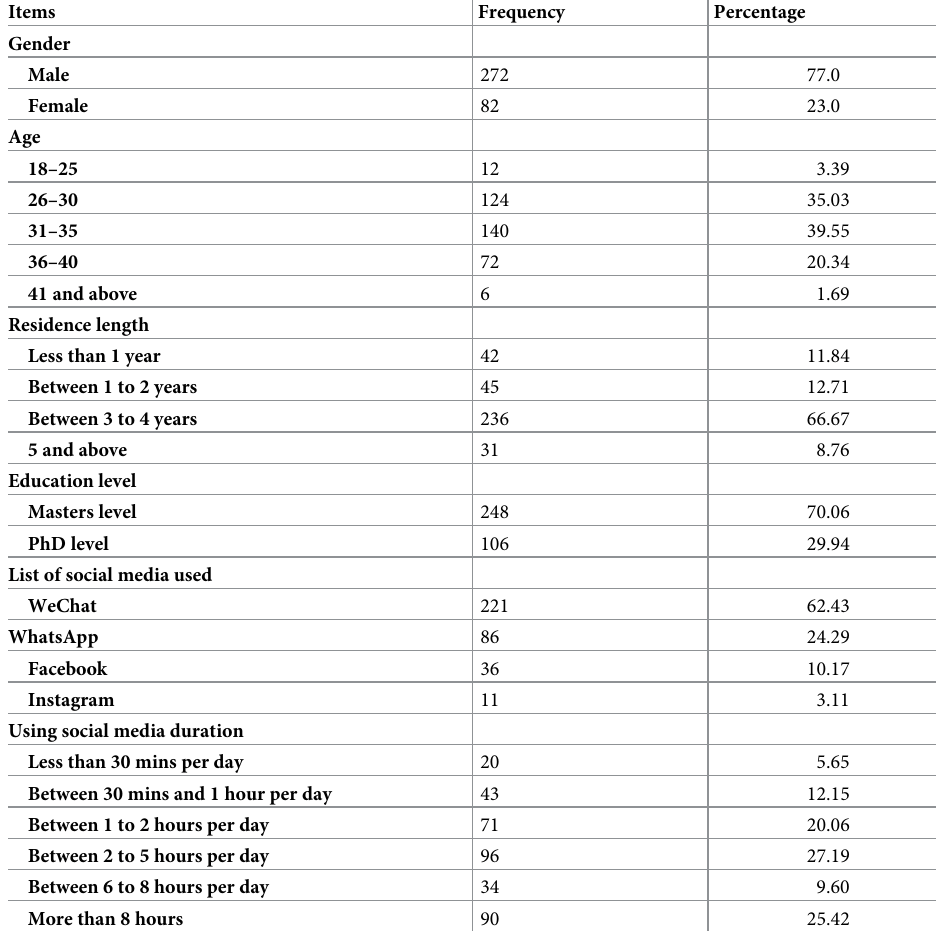
Table 1. Demographic information on international students in